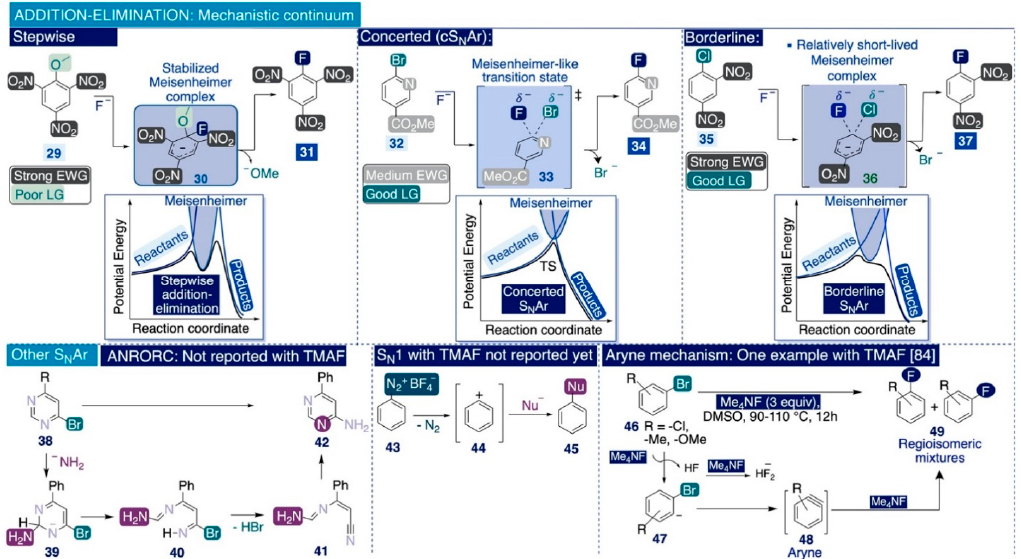
Scheme 7. Possible reaction mechanisms for S N Ar fluorination reactions with